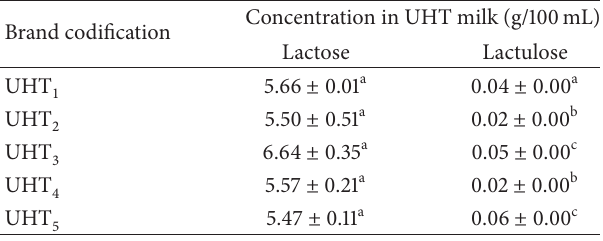
Table 1: Concentrations of lactose and lactulose found in five different commercial brands of UHT